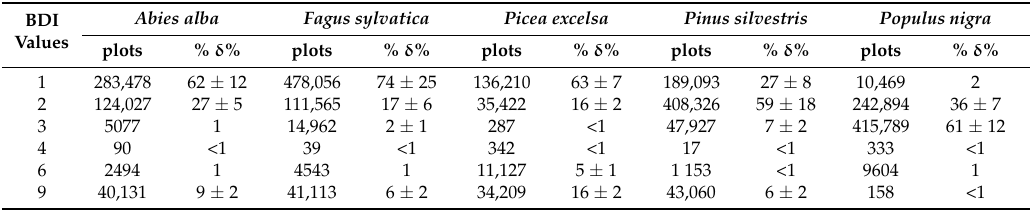
Table 4. Statistics of the potential BDI of the five tree species in 2050.